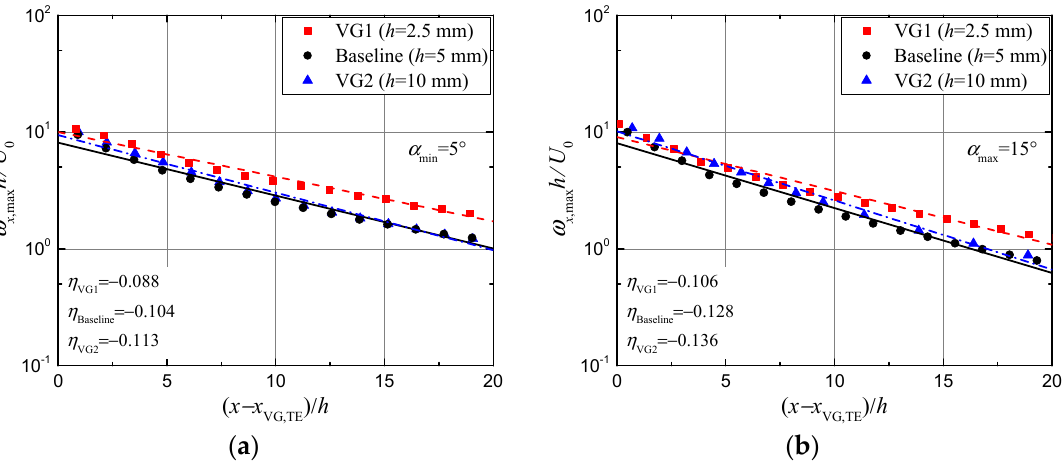
Figure 16. Streamwise peak vorticity decay downstream of the different VGs in height. ω x ,max denotes the streamwise peak vorticity, η the exponential decay exponent (related to the lines), and x VG,TE the chordwise location of VG trailing edge. ( a ) α = 5 ° (min.); ( b ) α = 15 ° (max.).